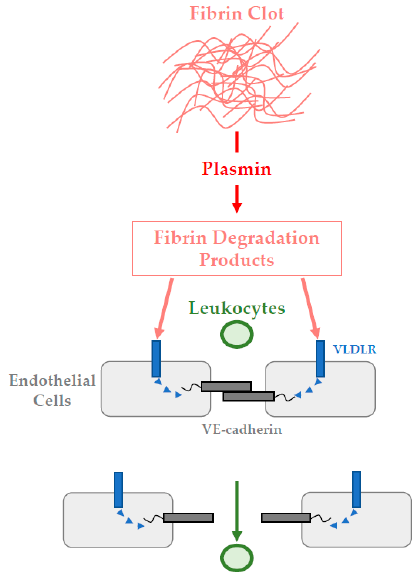
Figure 2. Fibrin clot degradation, and leukocytes transmigration triggering inflammatory response onset.